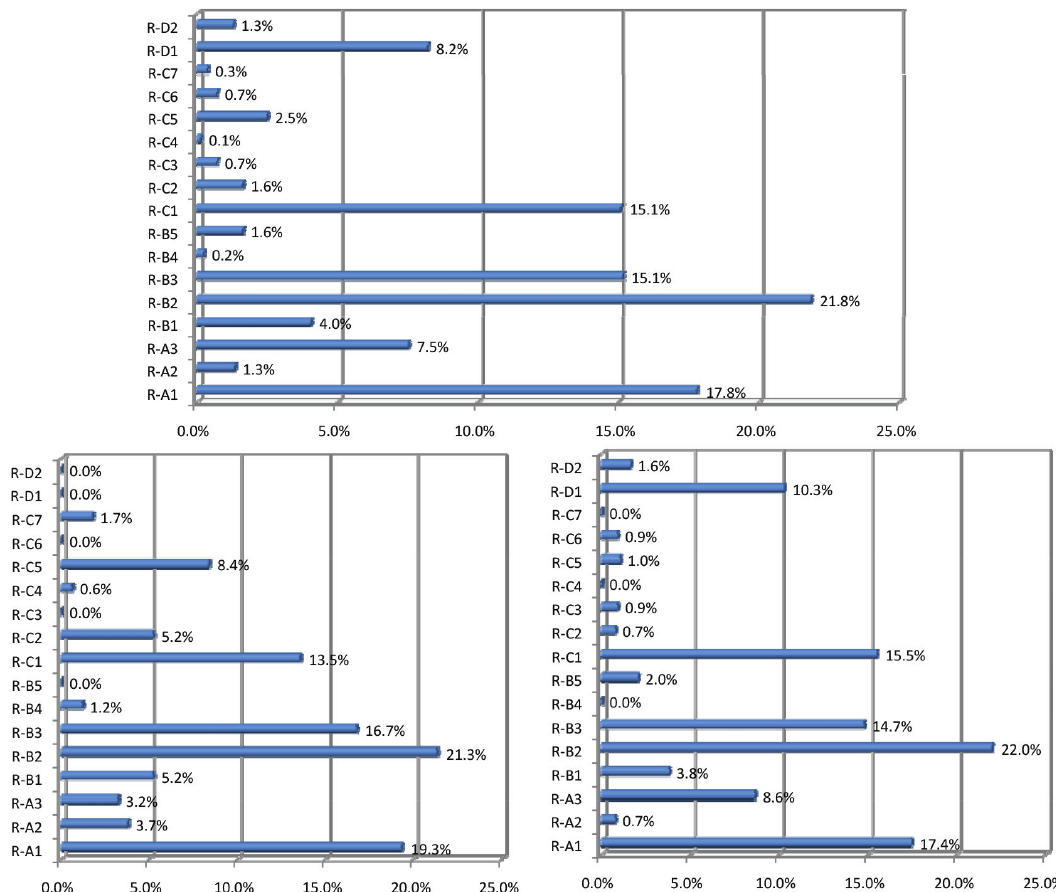
Fig. 9. Frequency of each repair technique predicted in the sample: considering all surfaces (top), in interior surfaces (down left) and in external surfaces (down